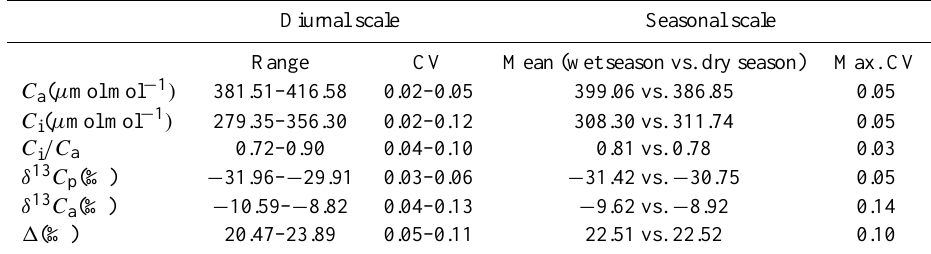
Table 1. The diurnal ranges, seasonal means, and coefficients of variation (CV) in ambient CO 2 concentration ( C a ), intercellular CO 2 concentration ( C i ) , the ratio of the intercellular and ambient CO 2 concentrations ( C i /C a ) , and carbon isotope compositions in leaf sap ( δ 13 C p ) , isotope compositions in the canopy air ( δ 13 C a ) and the photosynthetic 13 C discrimination ( 1) .